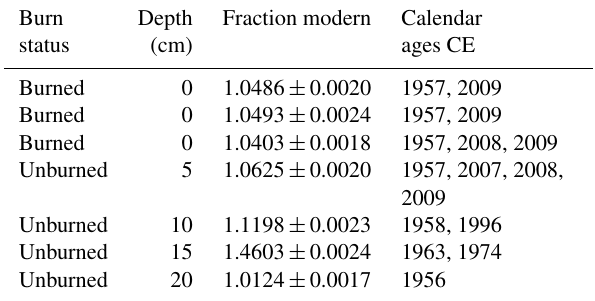
Table 3. The fraction of the modern standard and calibrated calen- dar age for each radiocarbon sample. Calendar ages are the inter- cepts for the fraction modern value with the calibration curve. We do not consider the oldest calendar